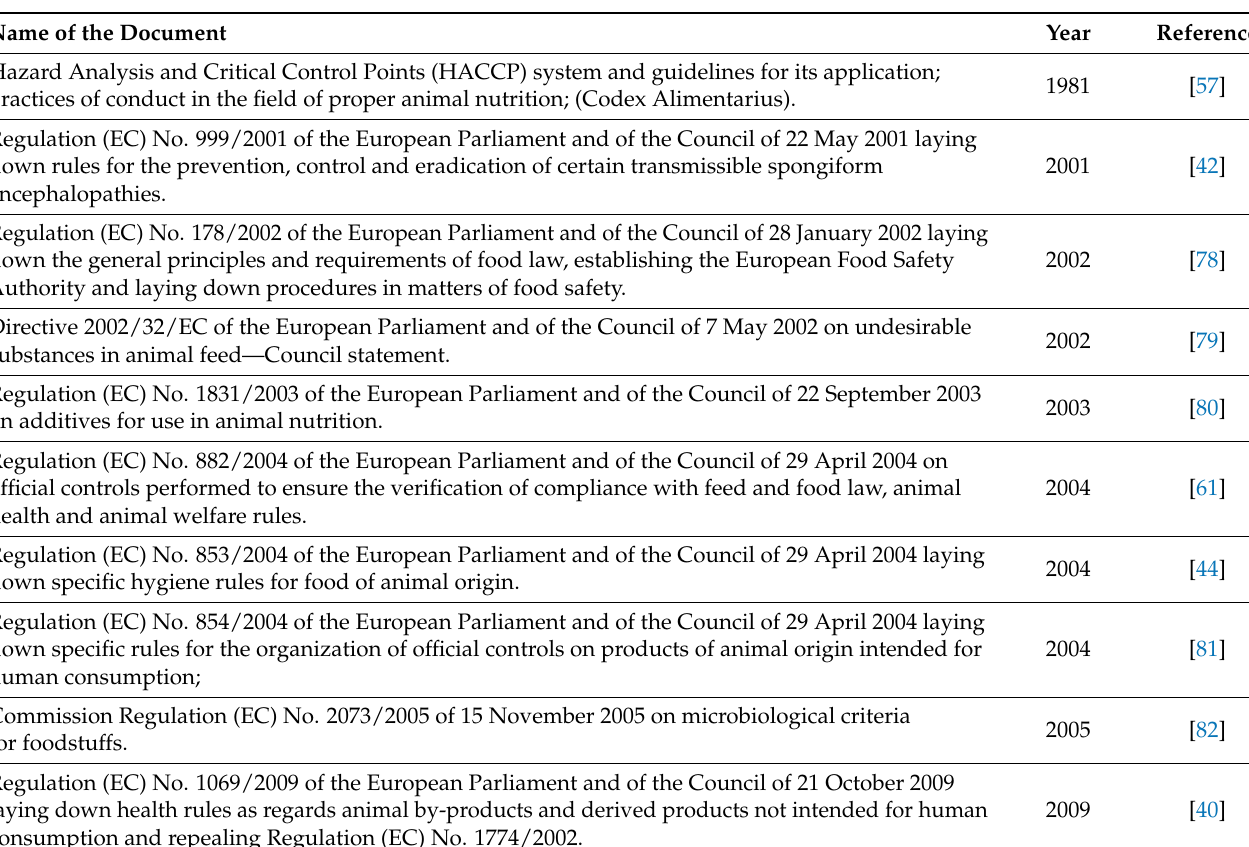
Table 2. Chronologically ordered set of the released legal documents regarding insect production for food and